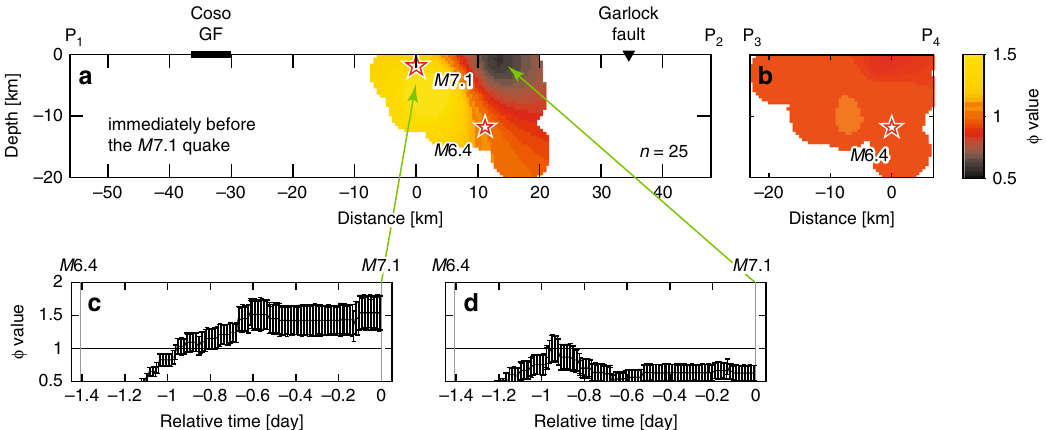
Fig. 5 Seismicity concentration/dispersion. a ϕ -values with n = 25 at the time immediately before the M 7.1 quake, based on seismicity ( M ≥ 3) during the period between M 6.4 and M 7.1 quakes along the fault ruptured by the M 7.1 quake. Note that seismicity used includes from the fi rst event after the M 6.4 quake to the last event before the M 7.1 quake. Stars indicate the M 6.4 and M 7.1 hypocenters. b Same as a for the cross-section along the fault ruptured by the M 6.4 quake. ( c , d ) Plot of ϕ as a function of relative time to the M 7.1 quake at the locations indicated by arrows. Uncertainties in ϕ , used to draw error bars in c and d , were computed by bootstrapping (see also Supplementary Fig. 10). The occurrence time of the M 6.4 quake, relative to that of the M 7.1 quake, is indicated by a grey vertical line at − 1.404 days. The relative time of the M 7.1 quake is 0 days (grey vertical line), as is obvious. See Supplementary Fig. 9 for other n